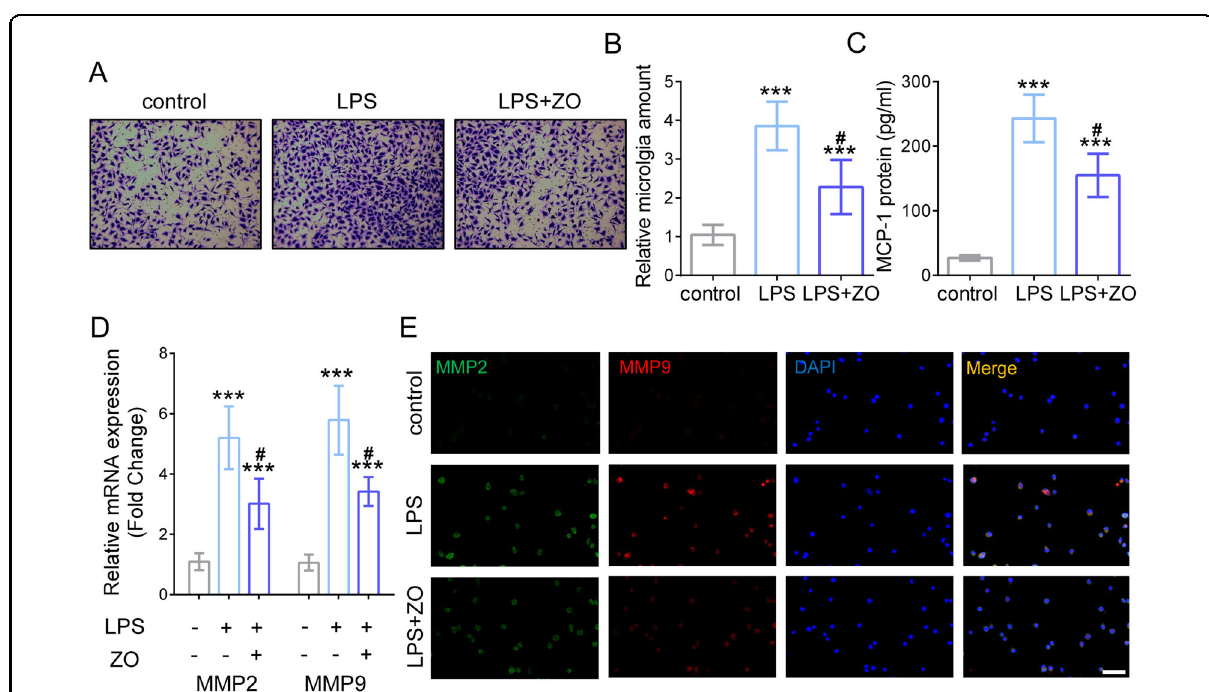
Fig. 3 Disruption of TAK1 inhibits microglia migration and MMPs production. A Trans-well assay with LPS and ZO administration treated as indicated. B The amount of microglia under LPS and TAK1 inhibition treatment. ∗∗∗ P < 0.001 versus control, # P < 0.05 versus LPS group. C Quanti fi cation of Monocyte chemoattractant protein-1 (MCP-1). ∗∗∗ P < 0.001 versus control, # P < 0.05 versus LPS group. D The RNA levels of MMP2 and MMP9 after LPS inducement and ZO employment. ∗∗∗ P < 0.001 versus control, # P < 0.05 versus L P S group. E Representative IF images of MMP2 and MMP9; Bar scale = 50 μ